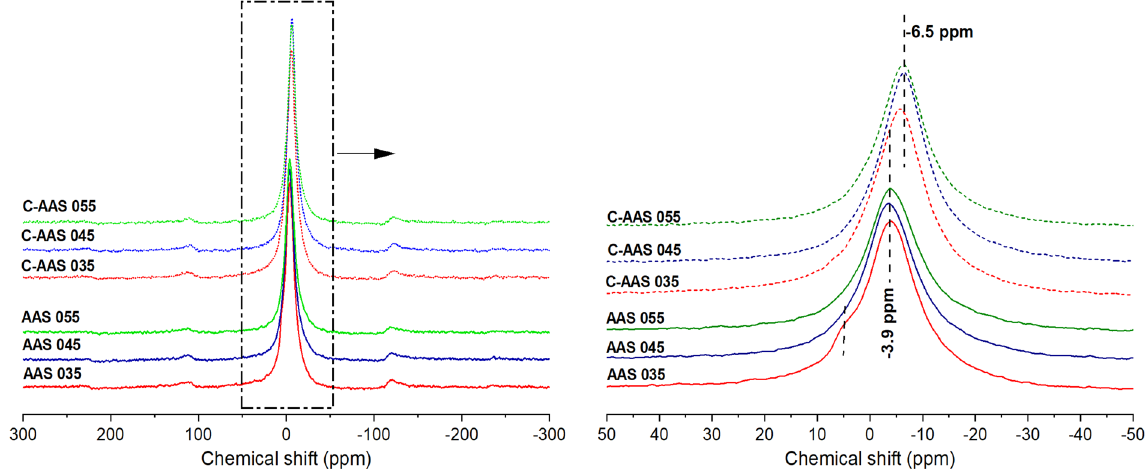
Figure 6. 23 Na MAS NMR spectra of uncarbonated alkali activated slags at 28 days of curing (AAS), and carbonated alkali activated slag after 28 days of carbonation with 1% CO 2 and 60% RH (C-AAS) at different water to binder